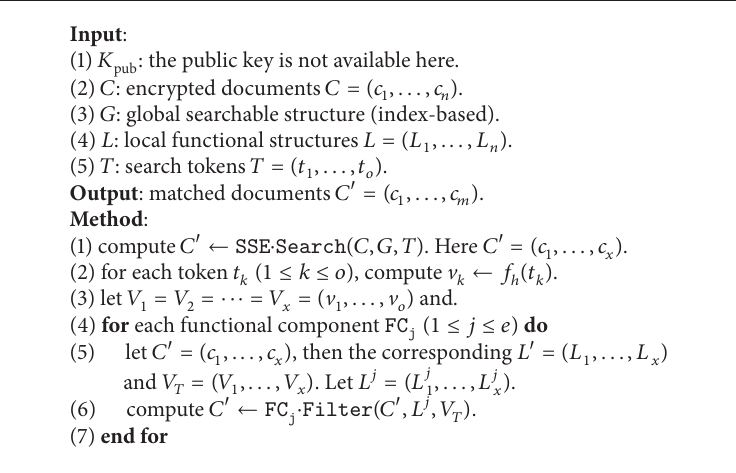
Algorithm 3: Search (symmetric): Search (𝐾